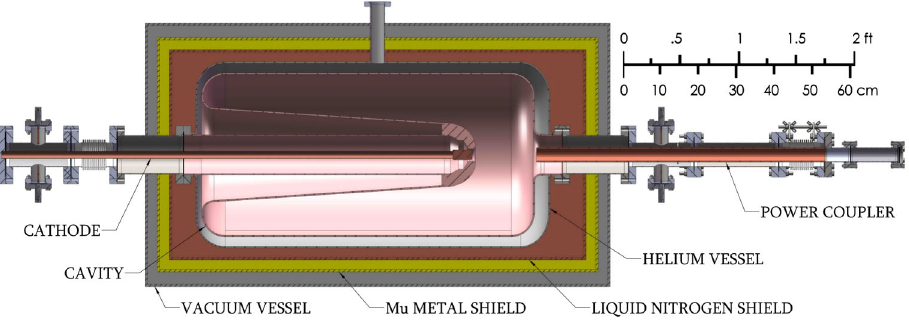
FIG. 15. 112 MHz—quarter wave BNL SRF gun cavity string. Courtesy of Terry Grimm, NIOWAVE